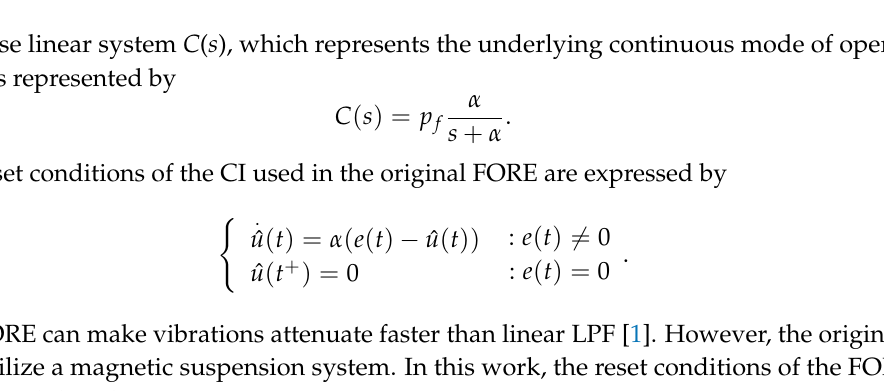
Figure 1. Block diagram of original first ‐ order reset element (FORE).